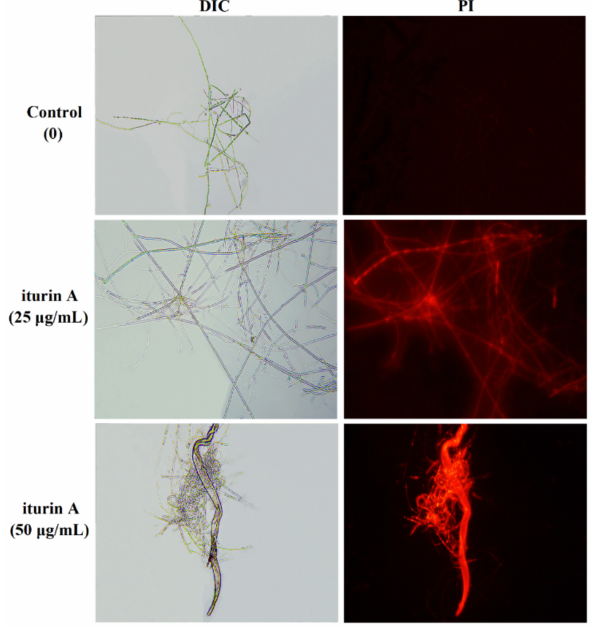
Figure 4. Effects of 25 and 50 µ g/mL iturin A on the cell membrane permeability of F. oxysporum as examined by optical microscopy.